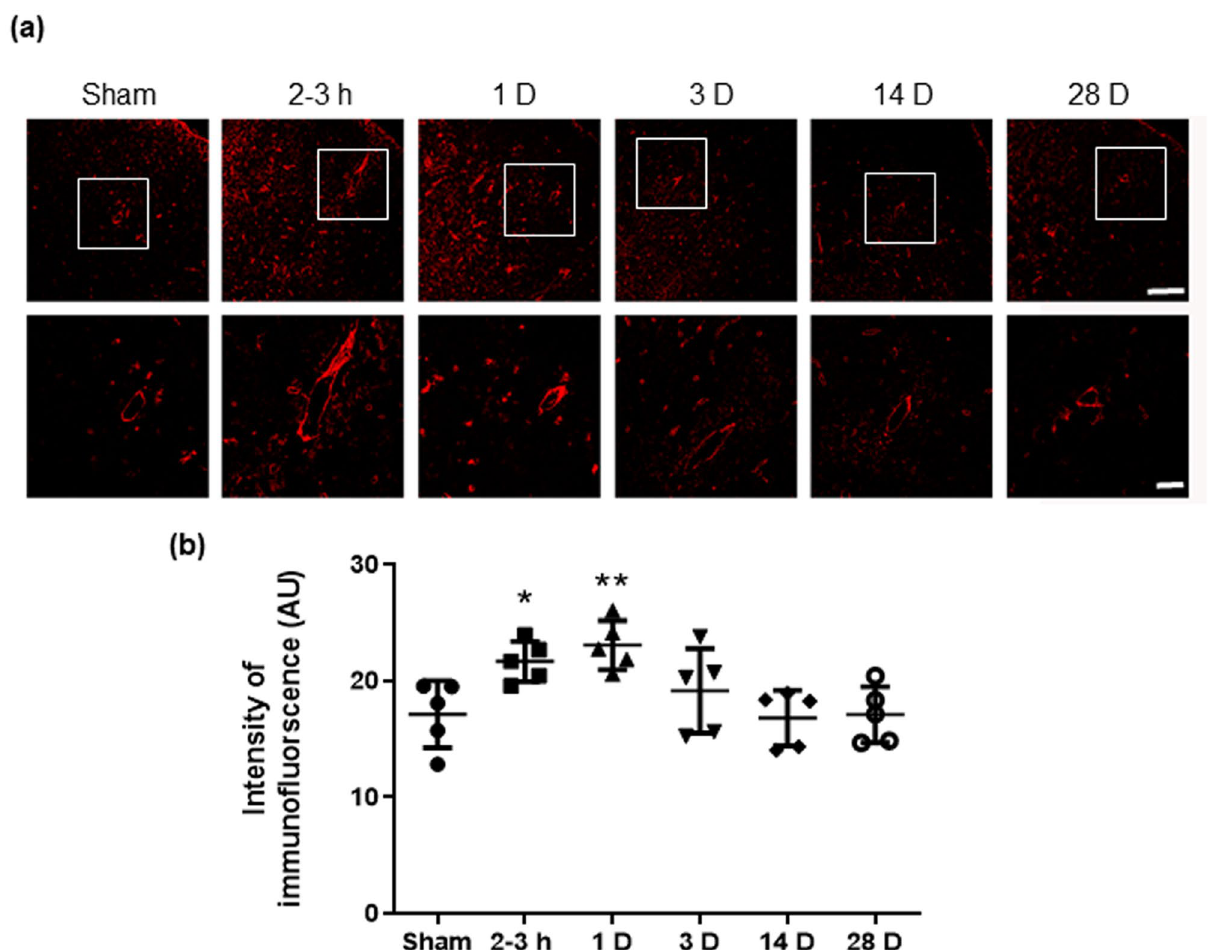
Figure 4. Increase in the expression of AQP-4 in cortex was induced by blast. ( a ) Representative immunofluorescent images of AQP-4 in sham and blast-exposed groups at different time points post-BOP. ( b ) Immunofluorescence intensity assessment of AQP-4 in sham and blast-exposed rats. BOP induced a significant increase in the expression of AQP-4 at 2-3 h and 1D after exposure, then returned to normal from 3D after exposure. Scale bar in ( a ) 100 μm and 25 μm in high magnification inserts. Data are mean ± SD, * p < 0.05, ** p < 0.01 for comparison of the specified time point post-blast with